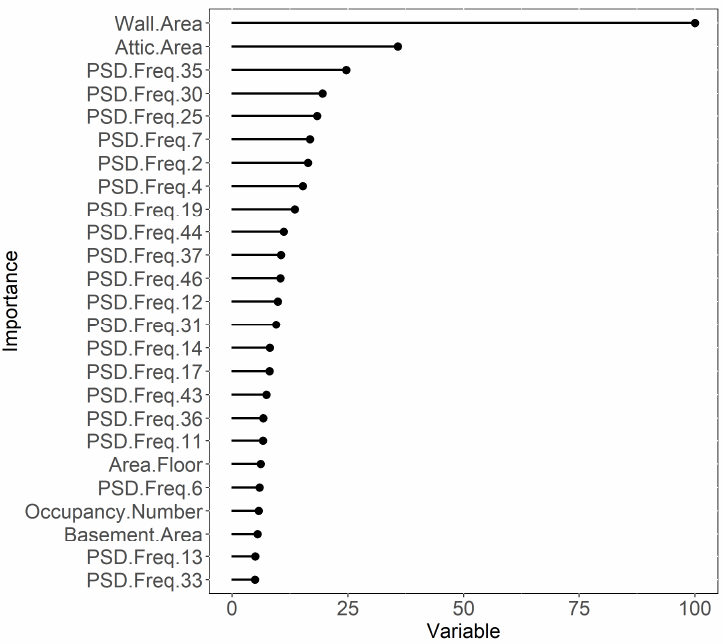
Figure 1. Variable importance plots including thermostat derived information for natural gas consumption